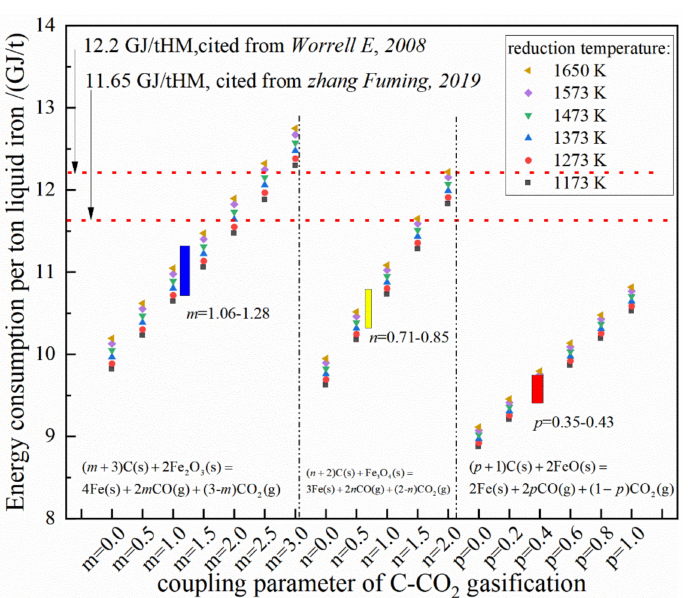
Figure 17. The energy consumption per ton liquid iron of varied coupling